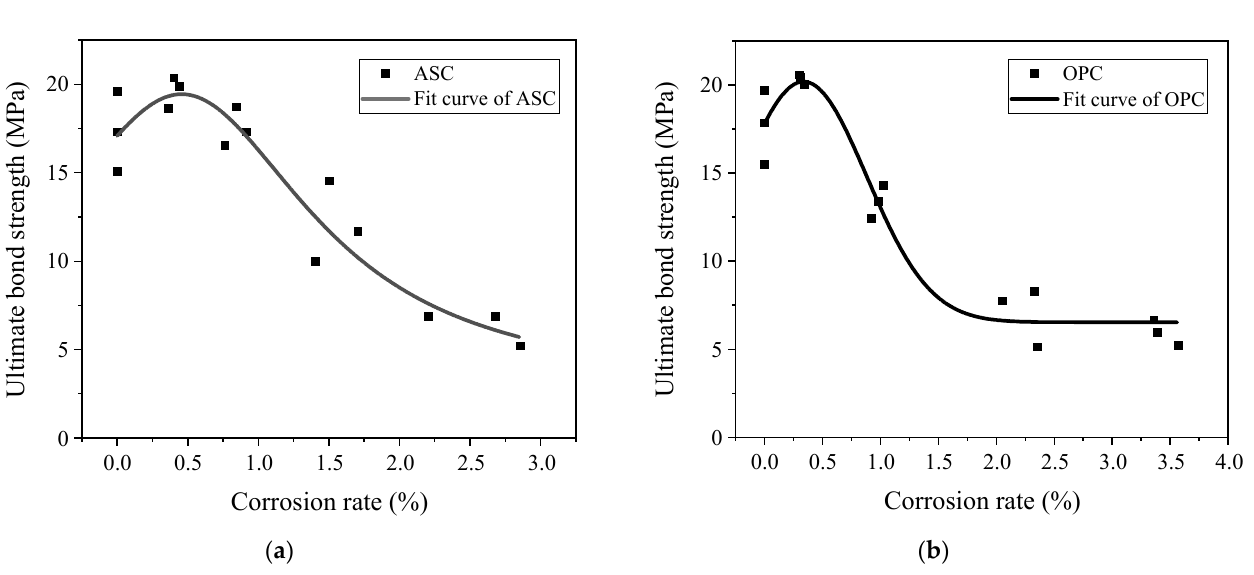
Figure 8. Relationship between the corrosion degree and the ultimate bond strength: ( a ) ASC and ( b ) OPC.